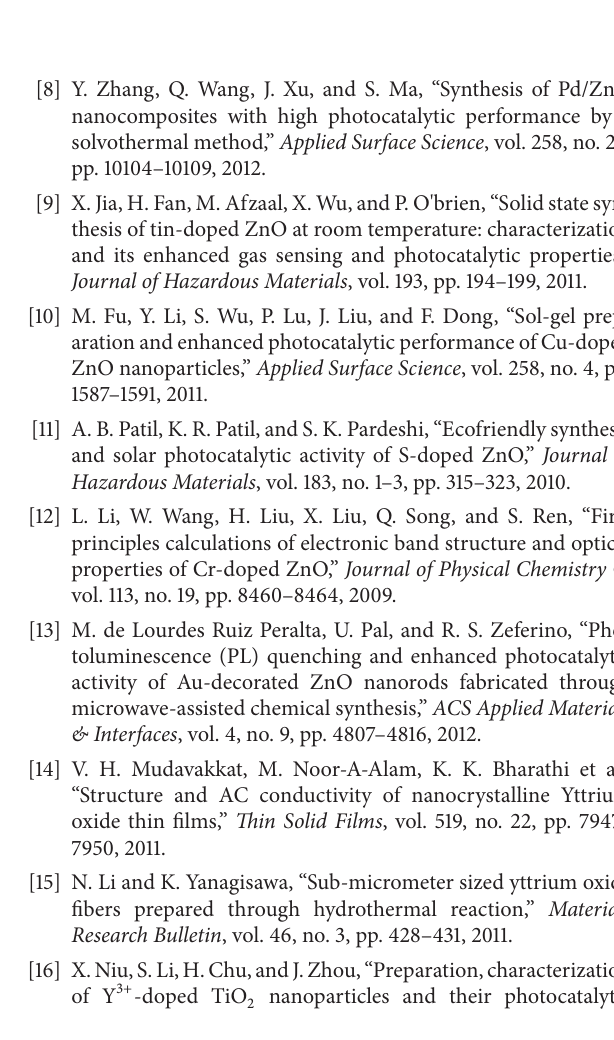
Figure 6: The adsorption of 2,4-DNP in the dark (a) and the effect of the Y 2 O 3 content of the Y 2 O 3 -ZnO on the photocatalytic degradation of 2,4-DNP